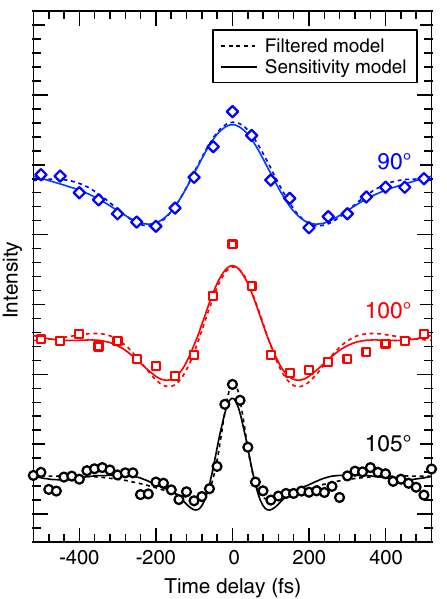
FIG. 4. Interferograms of CTR for 90° (diamond), 100° (square), and 105° (circle) accelerating phases in the linac measured with the bolometer. The interferograms were analyzed with the filtered model (dotted line) and the sensitivity model (solid line). The rms bunch lengths were determined to be 106, 76, and 21 fs at linac phases of 90°, 100°, and 105°, respectively, using the filtered model, while the corresponding values were 87, 63, and 26 fs using the sensitivity model. The interferograms were plotted with offsets and normalizing factors. Factors of 4, 2, and 1 were used at phases of 90°, 100°, and 105°,